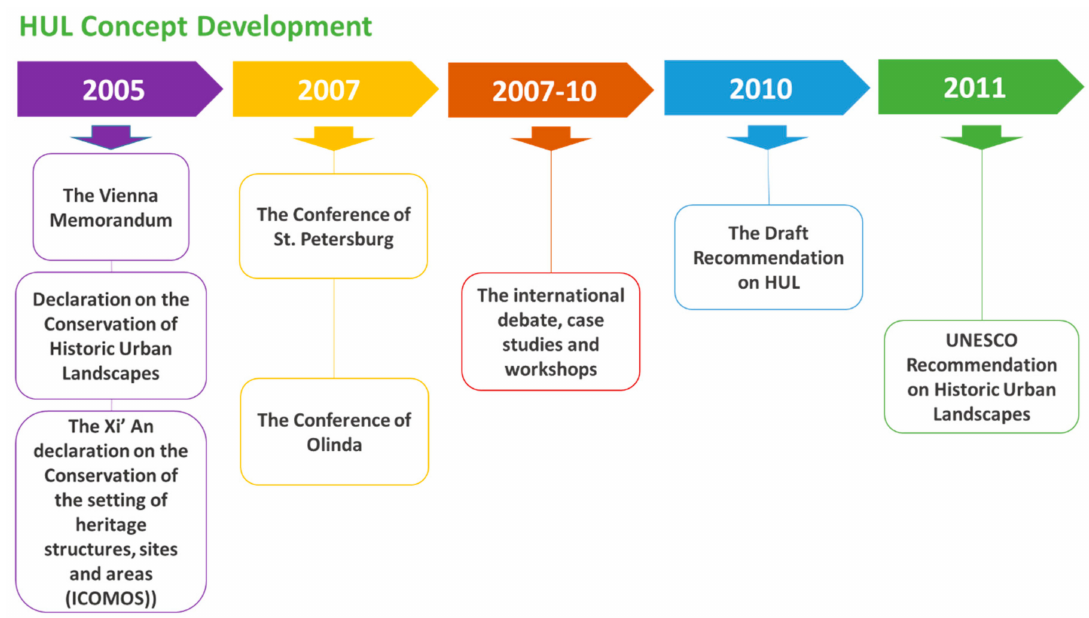
Figure 1. Diagram showing the sequential historical events for emerging and developing the concept of the historic urban landscape (HUL) approach. Adapted from